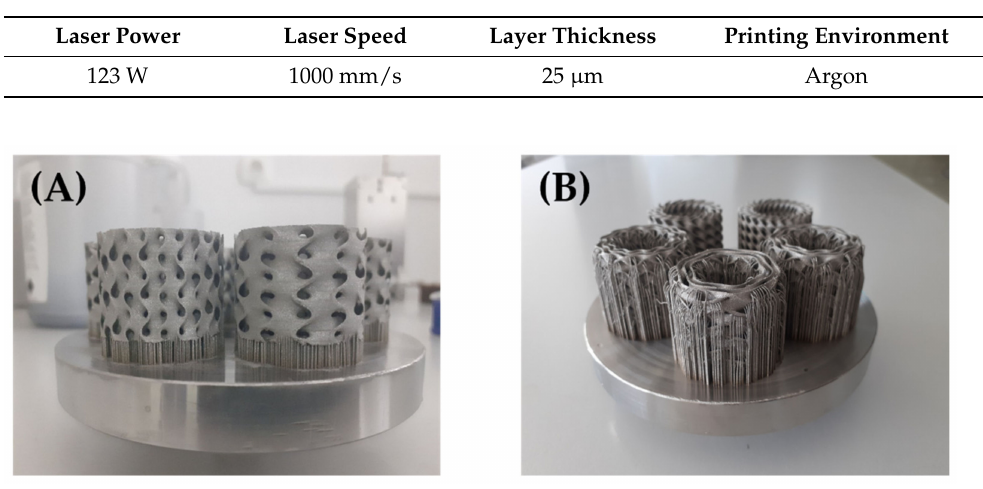
Table 2. Manufacturing parameters of the SLM process.